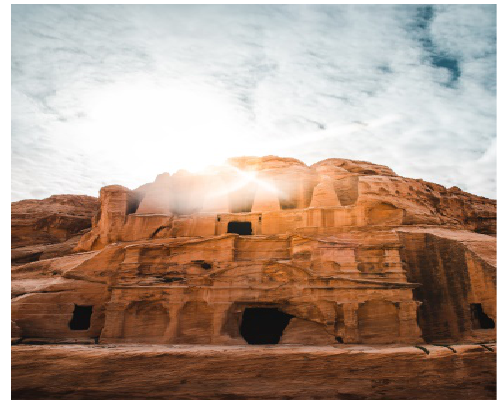
Figure 6.1 Bird